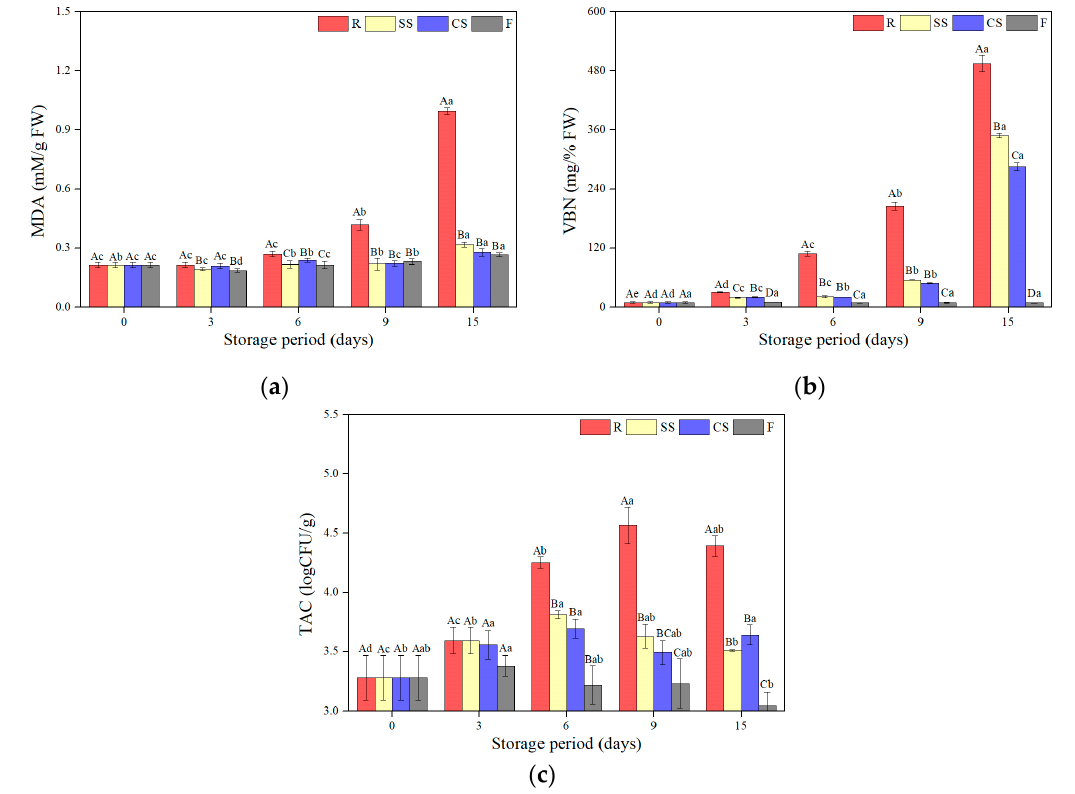
Figure 4. Changes in ( a ) thiobarbituric acid reactive substances (TBARS), ( b ) volatile basic nitrogen (VBN), and ( c ) total aerobic bacteria count (TAC) of raw laver ( Pyropia yenzoensis ) depending on various storage methods and periods. R, refrigeration; SS, supercooling by stepwise cooling algorithm; CS , constant temperature supercooling; F, freezing. A–D Means with different letters within the same storage period are significantly different ( p < 0.05). a–d Means with different letters within the same storage temperature are significantly different ( p < 0.05).